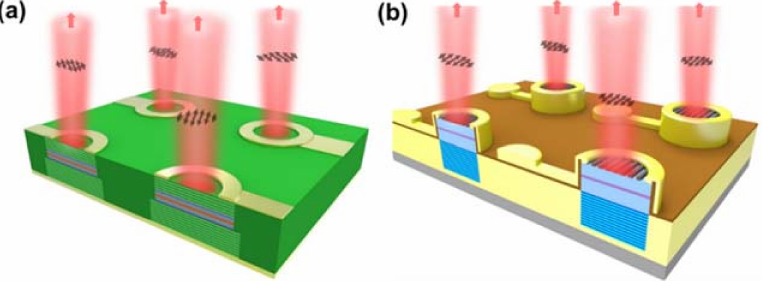
Figure 11. ( a ) Lasing with random polarization in conventional VCSEL arrays ( b ) lasing with pre-designed polarization by high-contrast grating (HCG)